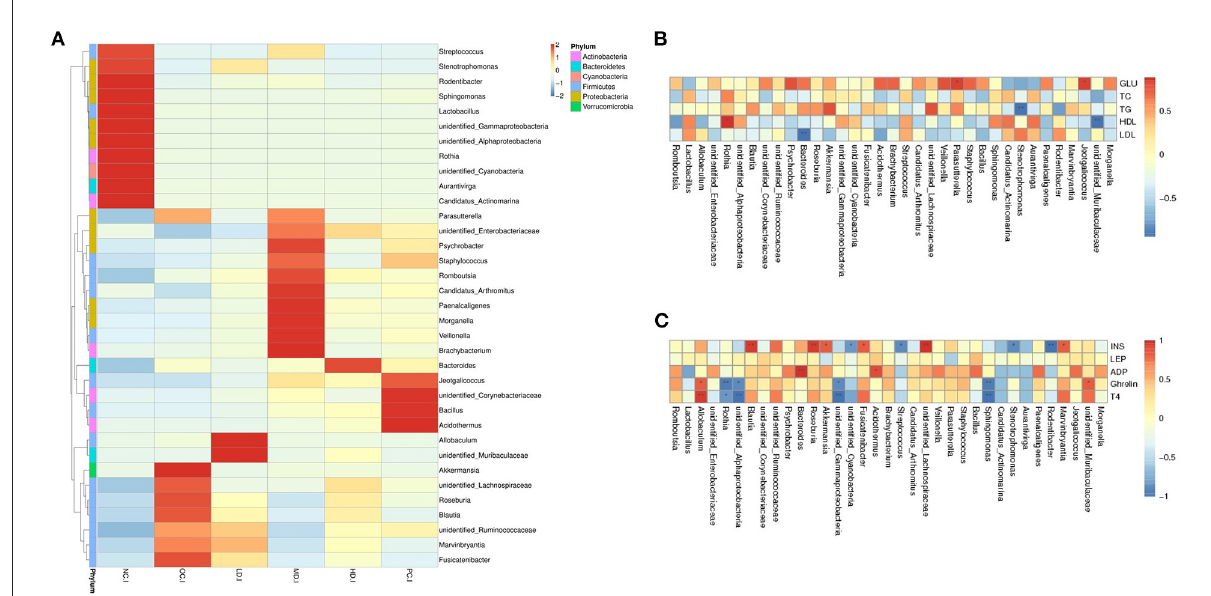
FIGURE3 Spearman association analysis between gut microbiota and metabolic parameters at the genus level (A) heatmap analysis at the genus level (B) spearman association analysis between gut microbiota and glucolipid metabolism parameters and (C) serum hormone. *Correlation was significant at the 0.05 level, **correlation was significant at the 0.01 level.